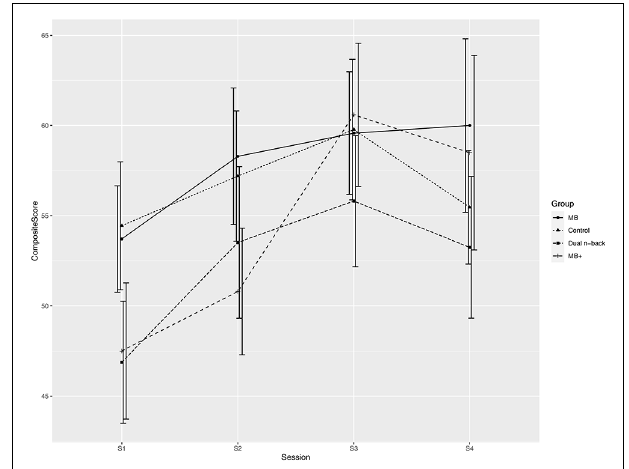
FIGURE 3 | Mean and standard error of the complex span composite score for each of the model-based (MB), control, dual n-back, and model-based plus (MB + ) training groups over the four sessions.